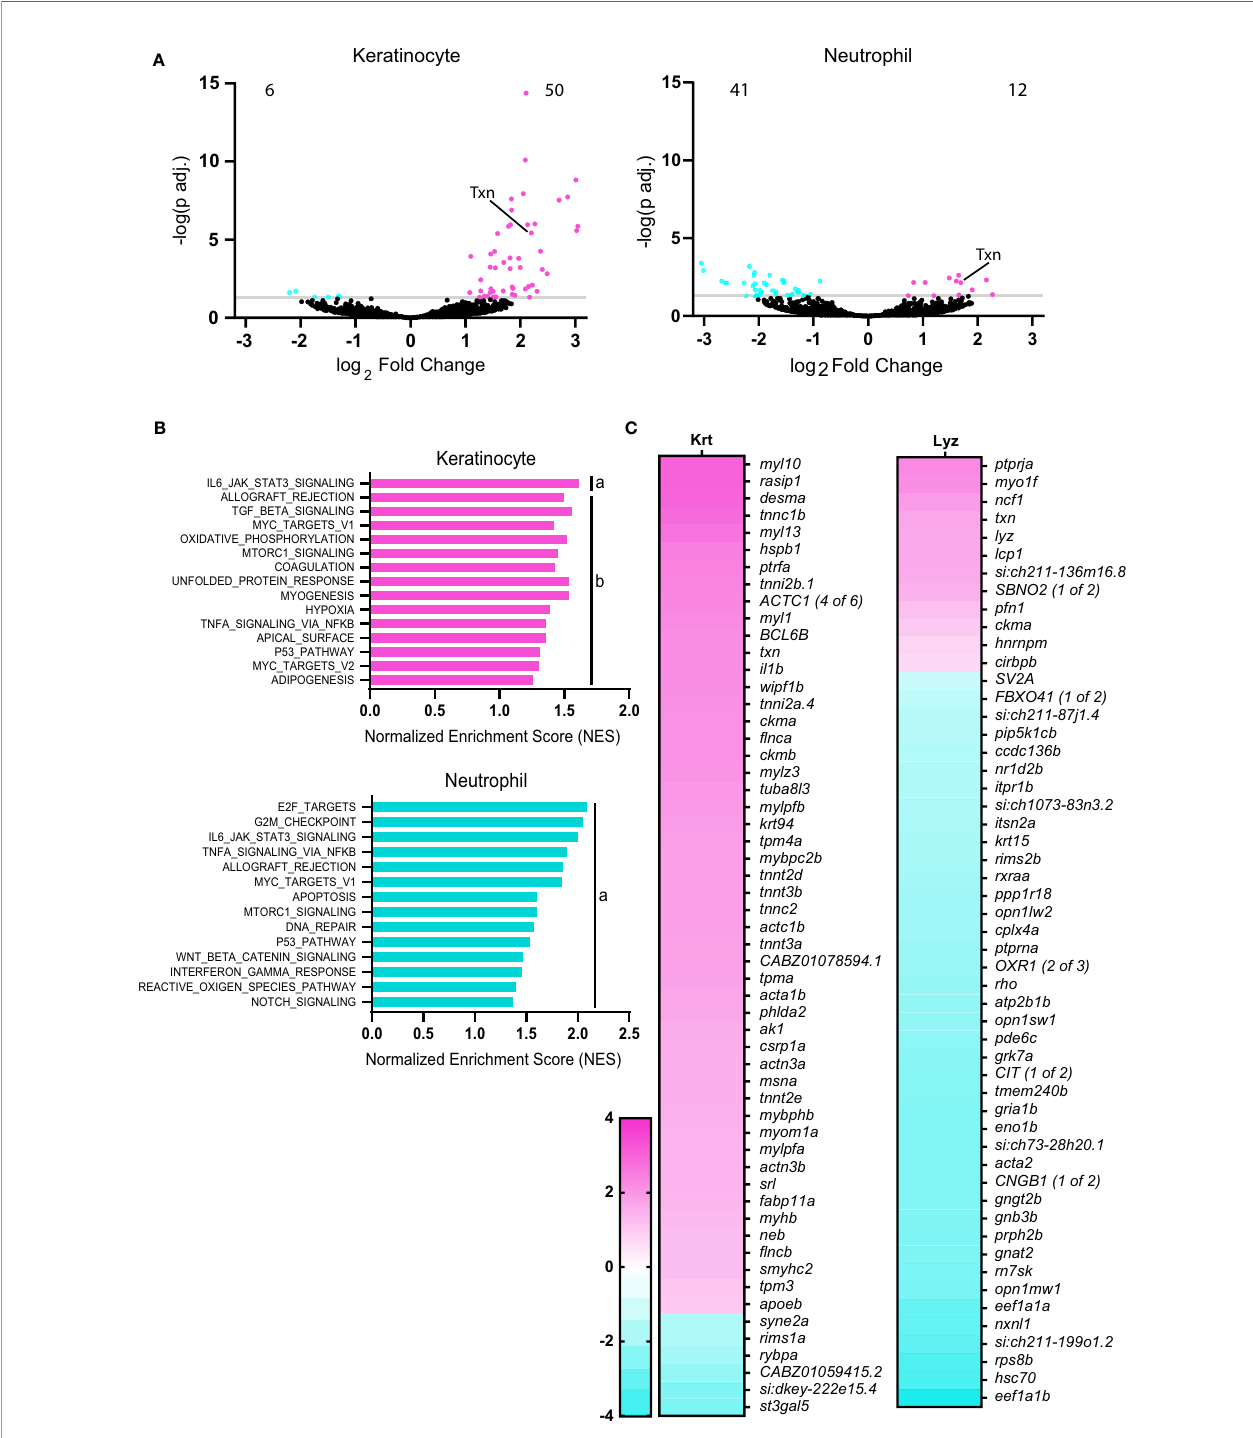
FIGURE 2 | Thioredoxin expression is induced in neutrophils and keratinocytes with HRas G12V transformation. (A) Volcano plots displaying number of signi fi cantly (adjusted p<0.05) downregulated and upregulated genes in keratinocytes and neutrophils in HRas G12V -keratinocyte expressing zebra fi sh larvae, compared to wild- type HRas controls. (B) Gene Set Enrichment Analysis (GSEA) of signi fi cantly enriched Hallmark pathways in neutrophils and keratinocytes for HRas G12V -keratinocyte expressing zebra fi sh. FDR q-value is (a) below 0.10 or (b) 0.10-0.25. (C) Heat maps displaying signi fi cantly differentially expressed genes (adjusted p<0.05) in keratinocytes (56 genes) and neutrophils (53